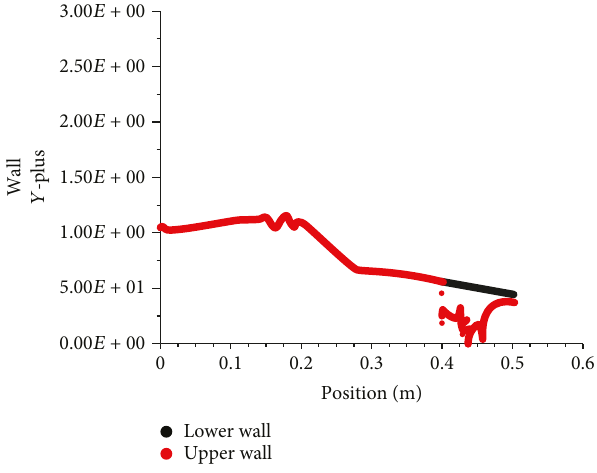
Figure 2: Wall Y -plus along the lower and upper walls. Table 1: Computational grids for grid independence